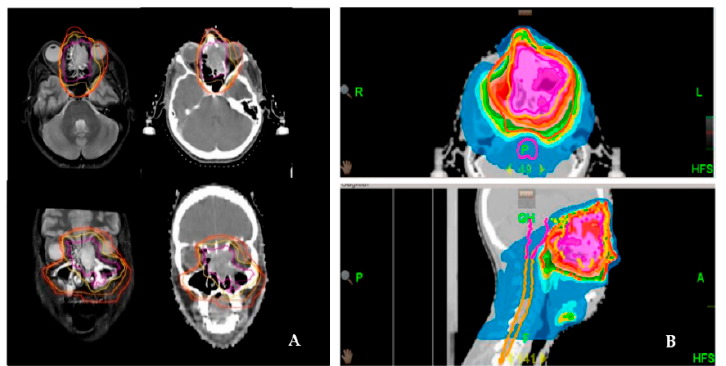
Figure 1. Delineation and dose distribution by helical tomotherapy of a left-sided paranasal carci- noma with orbital involvement. Definitive radiation treatment was performed using a SIB concept on Hi-Art tomotherapy ( A ). Delineation of the target volume on both CT and MRI scans (magenta: GTV; yellow: SIB-1; orange: SIB-2; red: PTV). ( B ). Dose distribution as a color wash.